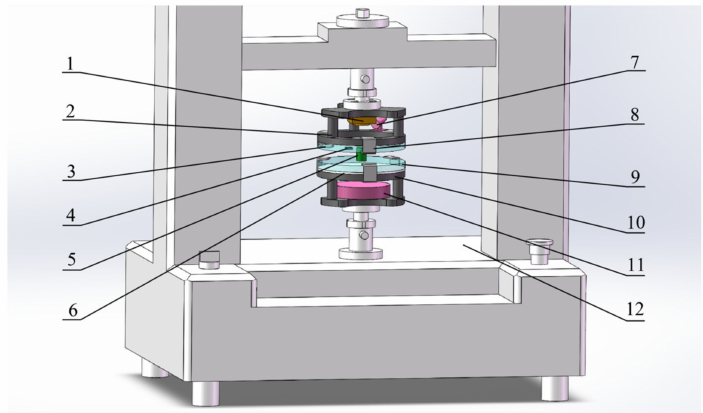
Figure 2. The Poisson’s ratio and Young’s modulus measurement test bench. 1. IMX415 camera module; 2. Upper contactor; 3. Upper glass plate; 4. Square block; 5. Stem specimens; 6. Background paper; 7. Upper LED light; 8. Clamp; 9. Lower glass plate; 10. Lower contactor; 11. Lower LED light; 12. Universal testing